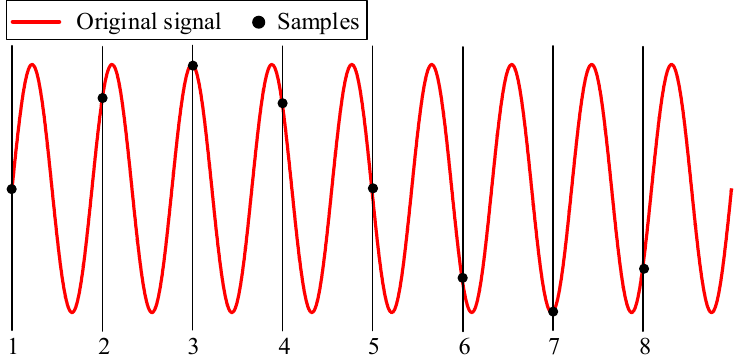
Figure 4. Example of the original signal and sampled points where y = 8 and x = 9 ( N = 8/9).